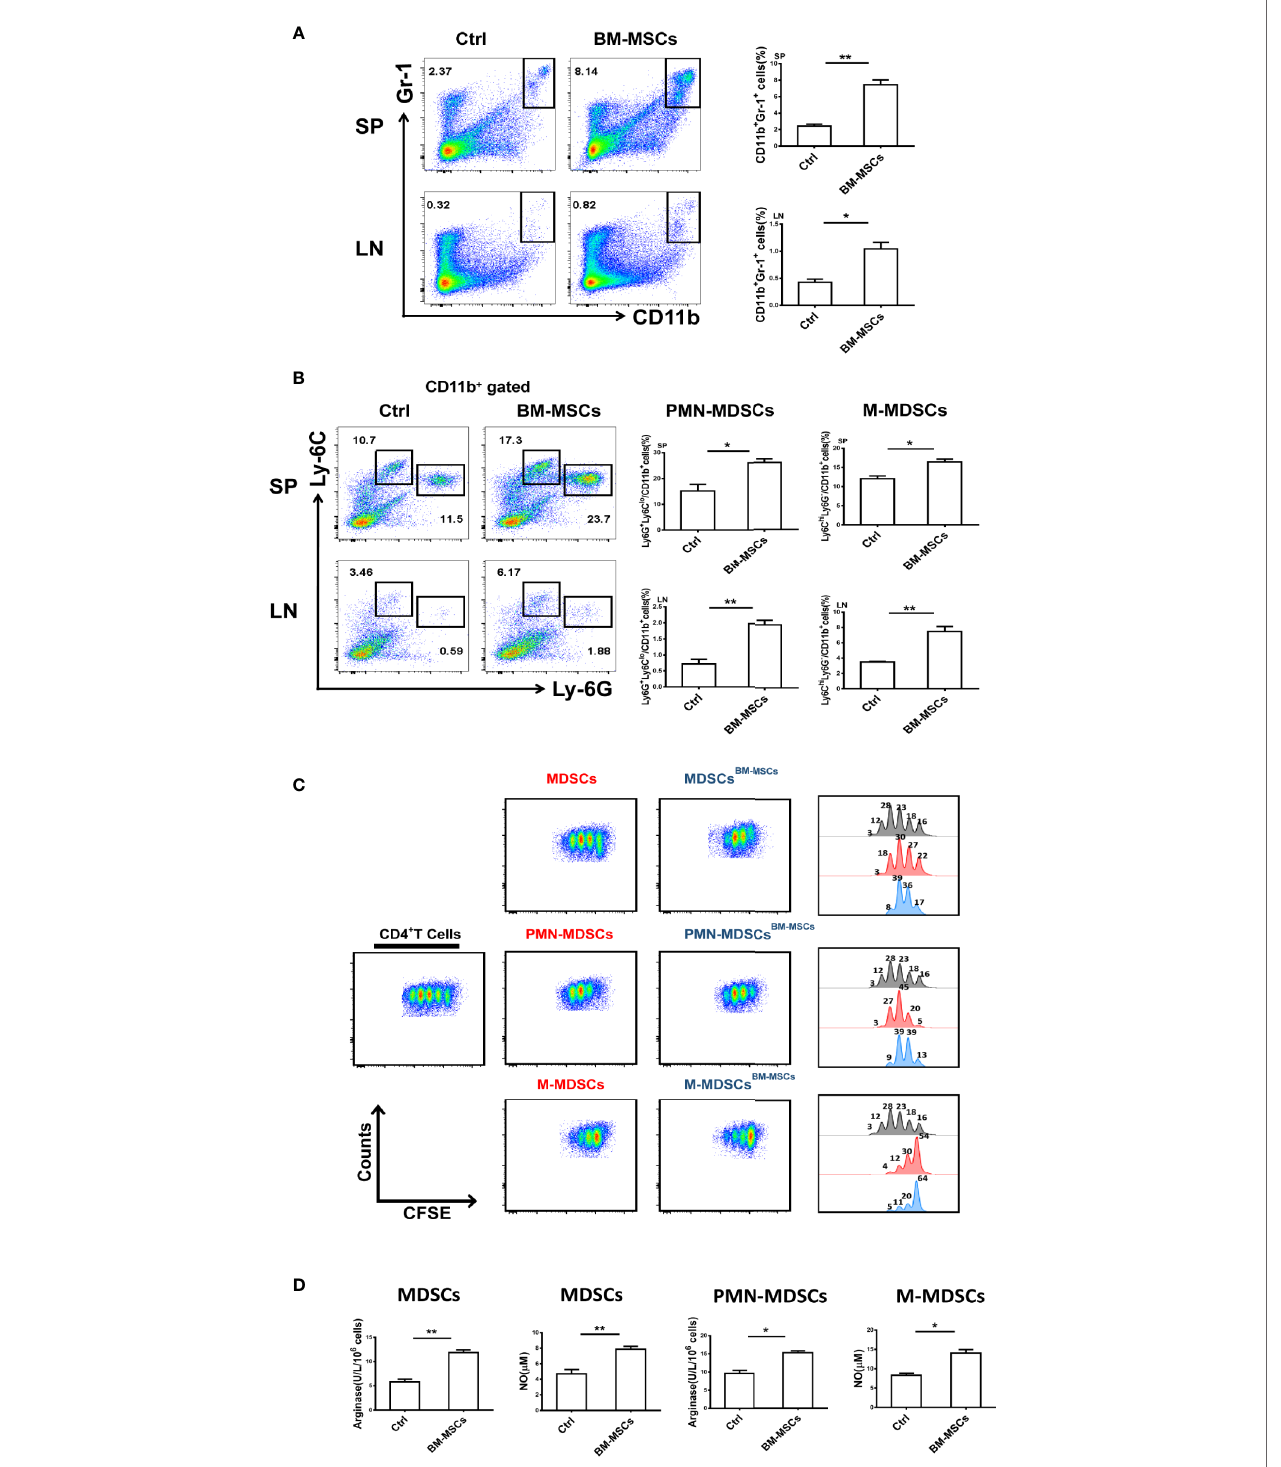
FIGURE 2 | BM-MSCs enhance the suppressive capacity of MDSCs in ESS mice. (A, B) Proportions of CD11b + Gr-1 + MDSCs (A) , M-MDSCs and PMN-MDSCs (B) were detected in SP and LN after BM-MSCs treatment (n=6). (C) Total MDSCs and their subsets from BM-MSCs treated group were isolated, and then co- cultured with CD4 + T cells in the presence of anti-CD3 and anti-CD28 mAbs for 72 h (MDSC:T cell ratio 1:1). CD4 + T cell proliferation was evaluated by staining with CFSE. (D) The activity of arginase and the level of NO were measured in MDSCs and their subsets (n=6). Data are shown as means ± SD from three independent experiments, n=6/group. **p < 0.01, *p <